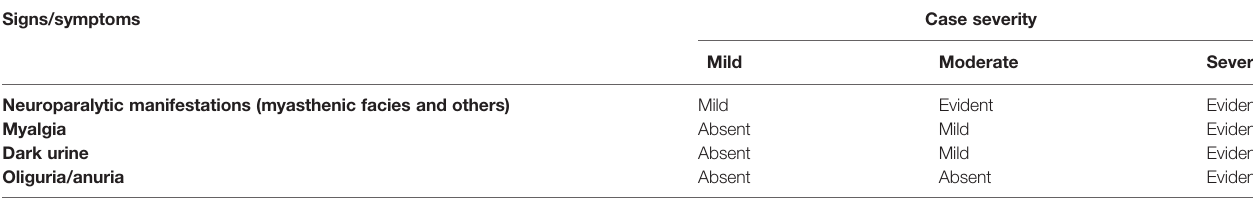
TABLE 5 | Factors associated with severity in C. d. ruruima envenomings reported in the state of Roraima, northern Brazilian Amazon, from 2010 to 2019. Severity# RR Underdosage